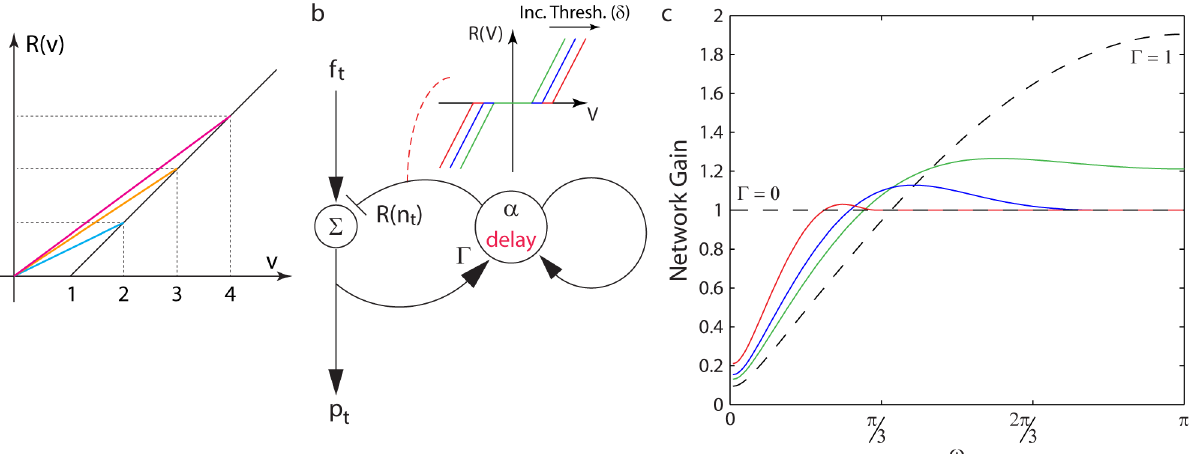
Fig 4. Rectification nonlinearity and its effect on the feedback inhibitory circuit. (a) Rectification nonlinearity (black), with threshold at v = 1. Linearized responses in color (cyan: min; magenta: max). (b) Nonlinear feedback inhibitory network. The nonlinearity (inset) is applied to the interneuron ’ s output. Nonlinearities with increasing thresholds are colored (green: min; red: max) (Methods). (c) Network gain at different input frequencies (note: the frequency space is in Z-space, i.e. defined with respect to the fixed time step of the network). The three colored curves are the nonlinear network response curves (computed using describing function analysis, colored as in (b)) (Methods). The dotted lines provide extreme parameter values for the linear network: Γ = 0,1.